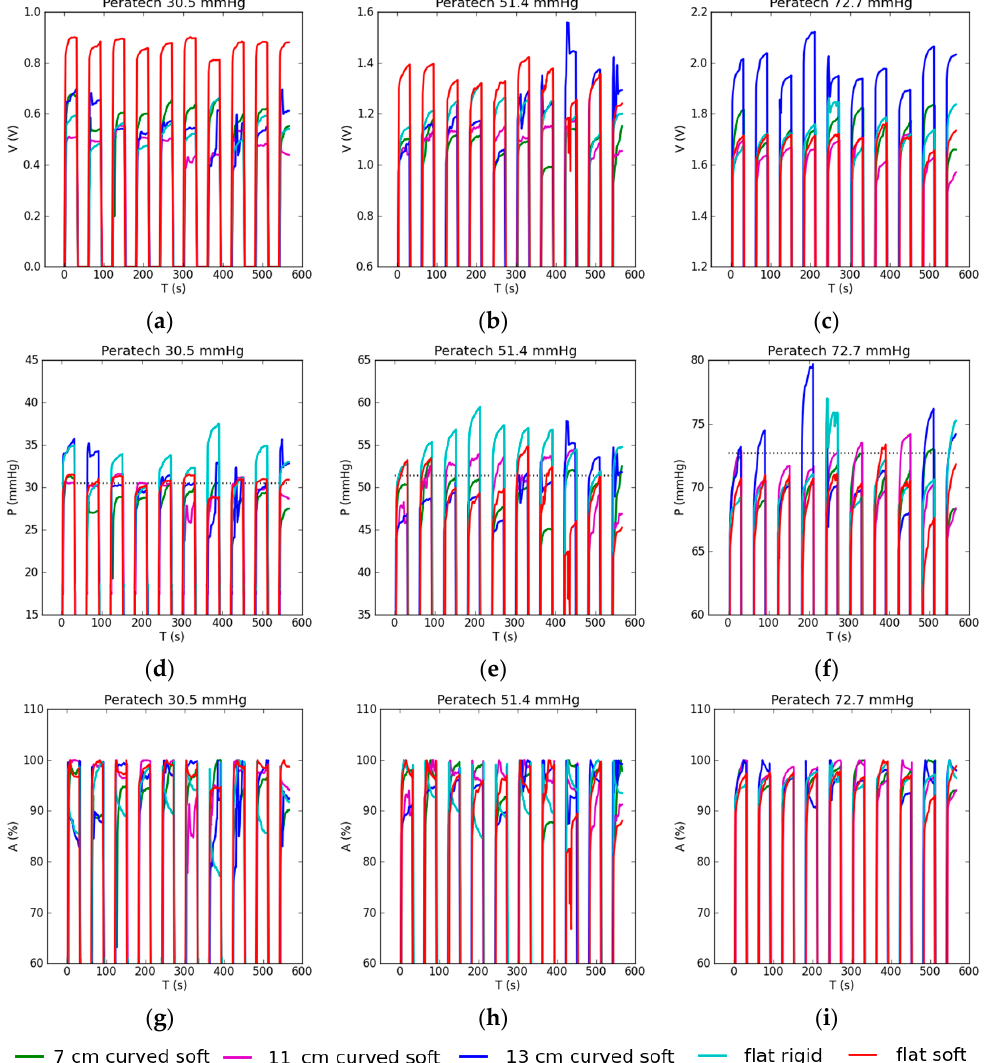
Figure 9. Dynamic testing results for Peratech sensor with applied pressure shown in the title: ( a – c ) sensor output voltage reading; ( d – f ) sensor pressure reading when sensor is recalibrated before each test. Dotted lines show corresponding applied gold standard pressures; ( g – i ) accuracy of the sensor pressure reading.